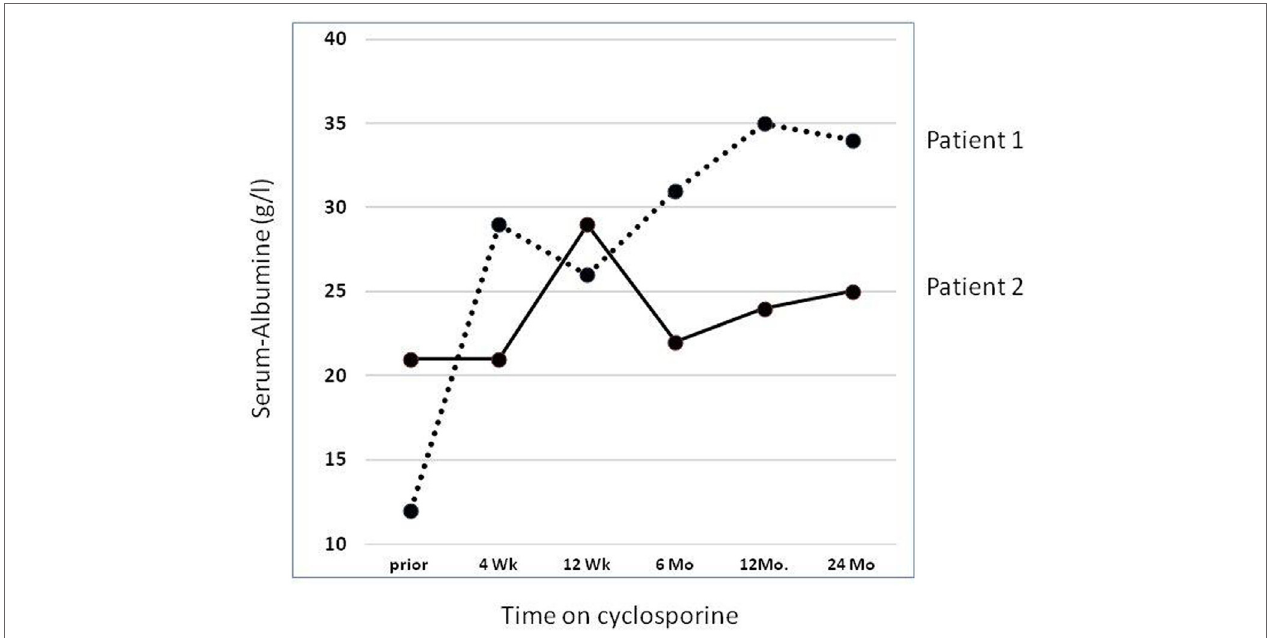
FiGURe 1 | Effect of cyclosporine treatment on evolution of serum albumin (sAlb) levels. Detailed data on two patients reported by Klaassen et al. (37). Dashed line: Patient 1 with compound heterozygous NPHS1 mutation (c.928G > A, p.Asp310Asn; c.2816-3T > G, p.?) rapidly showed complete remission with concomitant normalization of sAlb. Solid line: Patient 2 with a homozygous NPHS2 mutation (NPHS2: c.467dupT, p.Leu156Phefs*11) achieved partial remission and albumin infusions were discontinued. He reached ESRD after 5.0